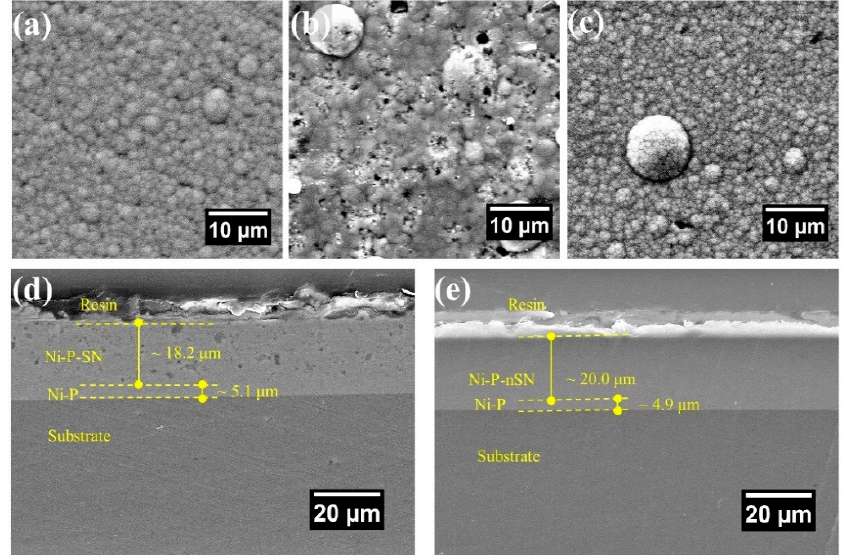
Figure 14. Surface topologies of ( a ) Ni-P, ( b ) Ni-P-SN, ( c ) Ni-P-nSN composite, ( d , e ) Ni-P-SN and Ni-P-nSN composed of a coating (~5 µm). Reprinted with permission from Ref. [85]. MDPI (2022).